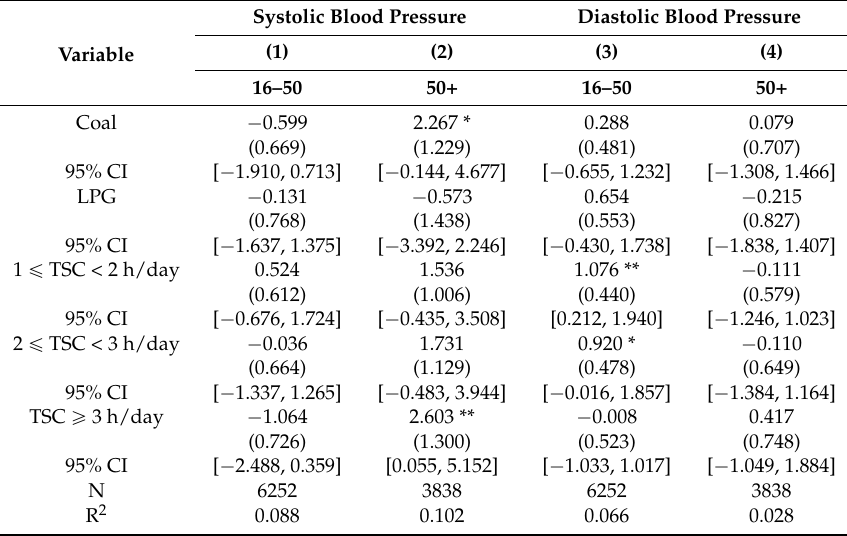
Table 7. Fixed effects estimates for the effect of household cooking fuels on women’ blood pressure in rural area: CHNS